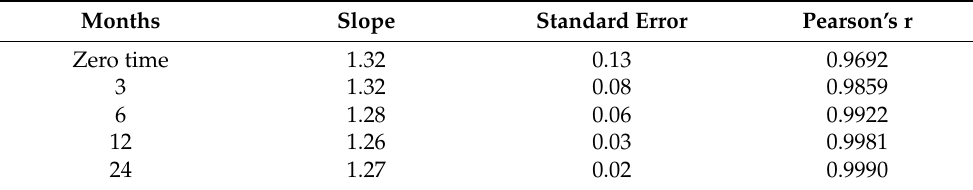
Table 5. Oxi-hydroxides identified by Raman spectroscopy in the surface of WS patinas (natural and accelerated patinas) at zero time and after 3, 6, 12 and 24 months of exposure in the urban atmosphere of Madrid. Treatment